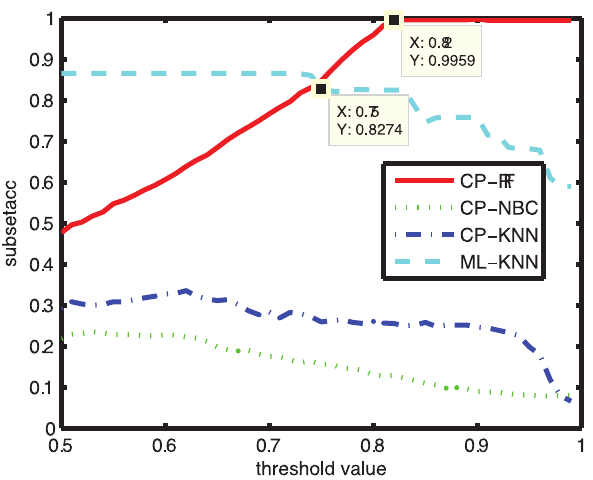
Figure 3. Comparison of subset accuracy with different thresholds.